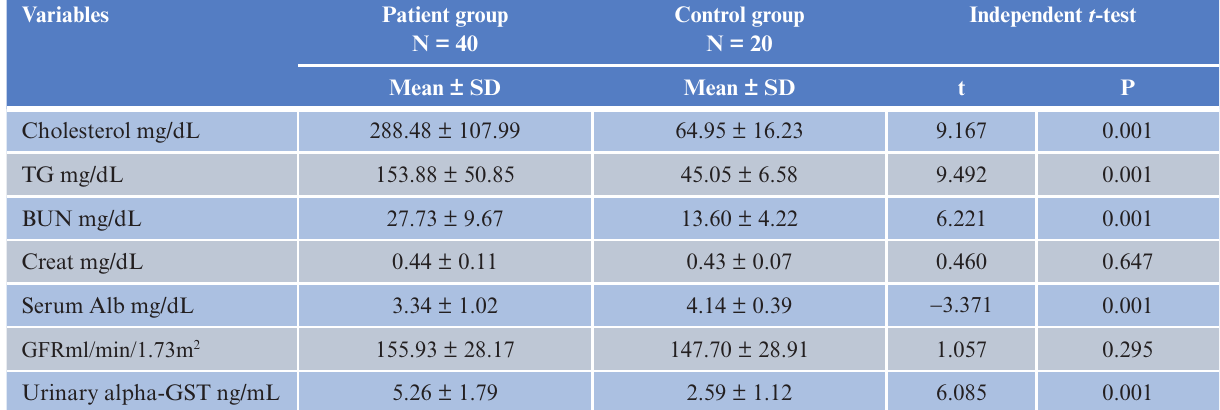
Table 2: Comparison between patient group and the control group with regard to laboratory data.